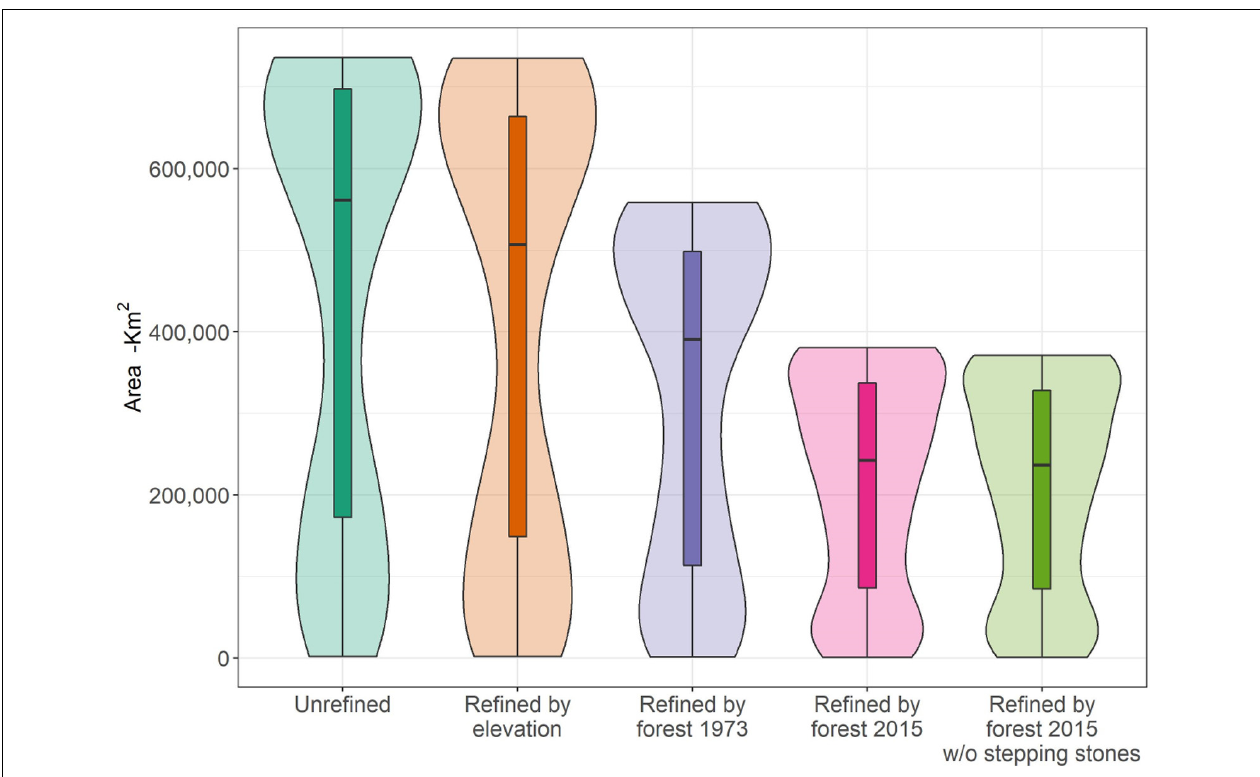
FIGURE 1 | Boxplot showing changes in habitat area for 245 Borneo forest mammals and birds during the range refinement process starting with the unrefined range (aqua green), after refined by elevation (orange), and after further refinement by forest in 1973 (purple), and forest in 2015 (pink). Last boxplot (lime green) shows the ranges refined by forest in 2015 after removal of stepping stone patches ( < 1.8 km 2 ). Each bar represents the median and distribution of range areas (in km 2 ) throughout the refining process. Background violin plots show the detailed distribution of the